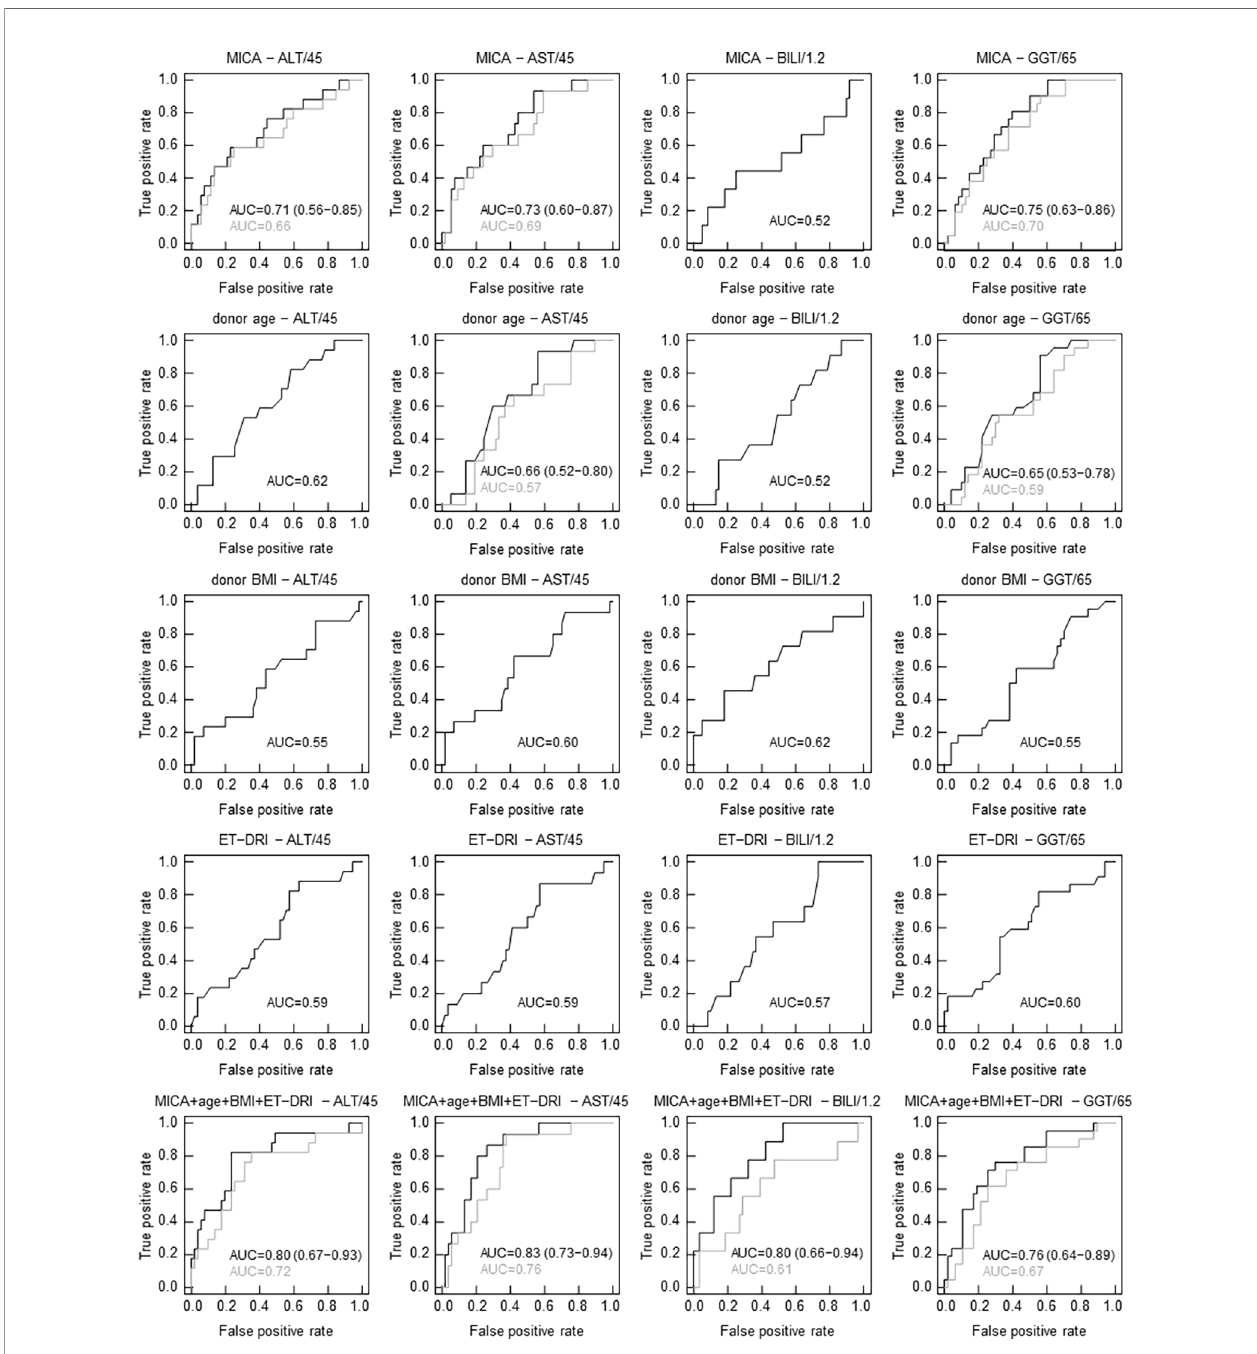
FIGURE 3 | In contrast to clinical parameters, MICA mRNA expression correlates with graft function 24 months following LT. Receiver operating characteristics (ROC) curves from univariate and multivariate logistic regression (LR) analyses to discern functional livers from those with impaired function (based on a cutoff for ALT of 45 U/l, for AST of 45 U/l, for bilirubin of 1.2 mg/dl and for GGT of 65 U/l in serum 24 months post-transplantation). ROC curves showing true-positive rate (sensitivity) versus false-positive rate (1-speci fi city) for individual LR classi fi ers based on MICA mRNA expression, donor age, donor BMI, ET-DRI and combined multivariate LR classi fi ers. Results from leave-one-out cross-validation (LOOCV) are indicated in gray. The area under the ROC curve (AUC) serves as a predictive value. (LOOCV was only evaluated and shown when AUC ≥ 0.65 including all